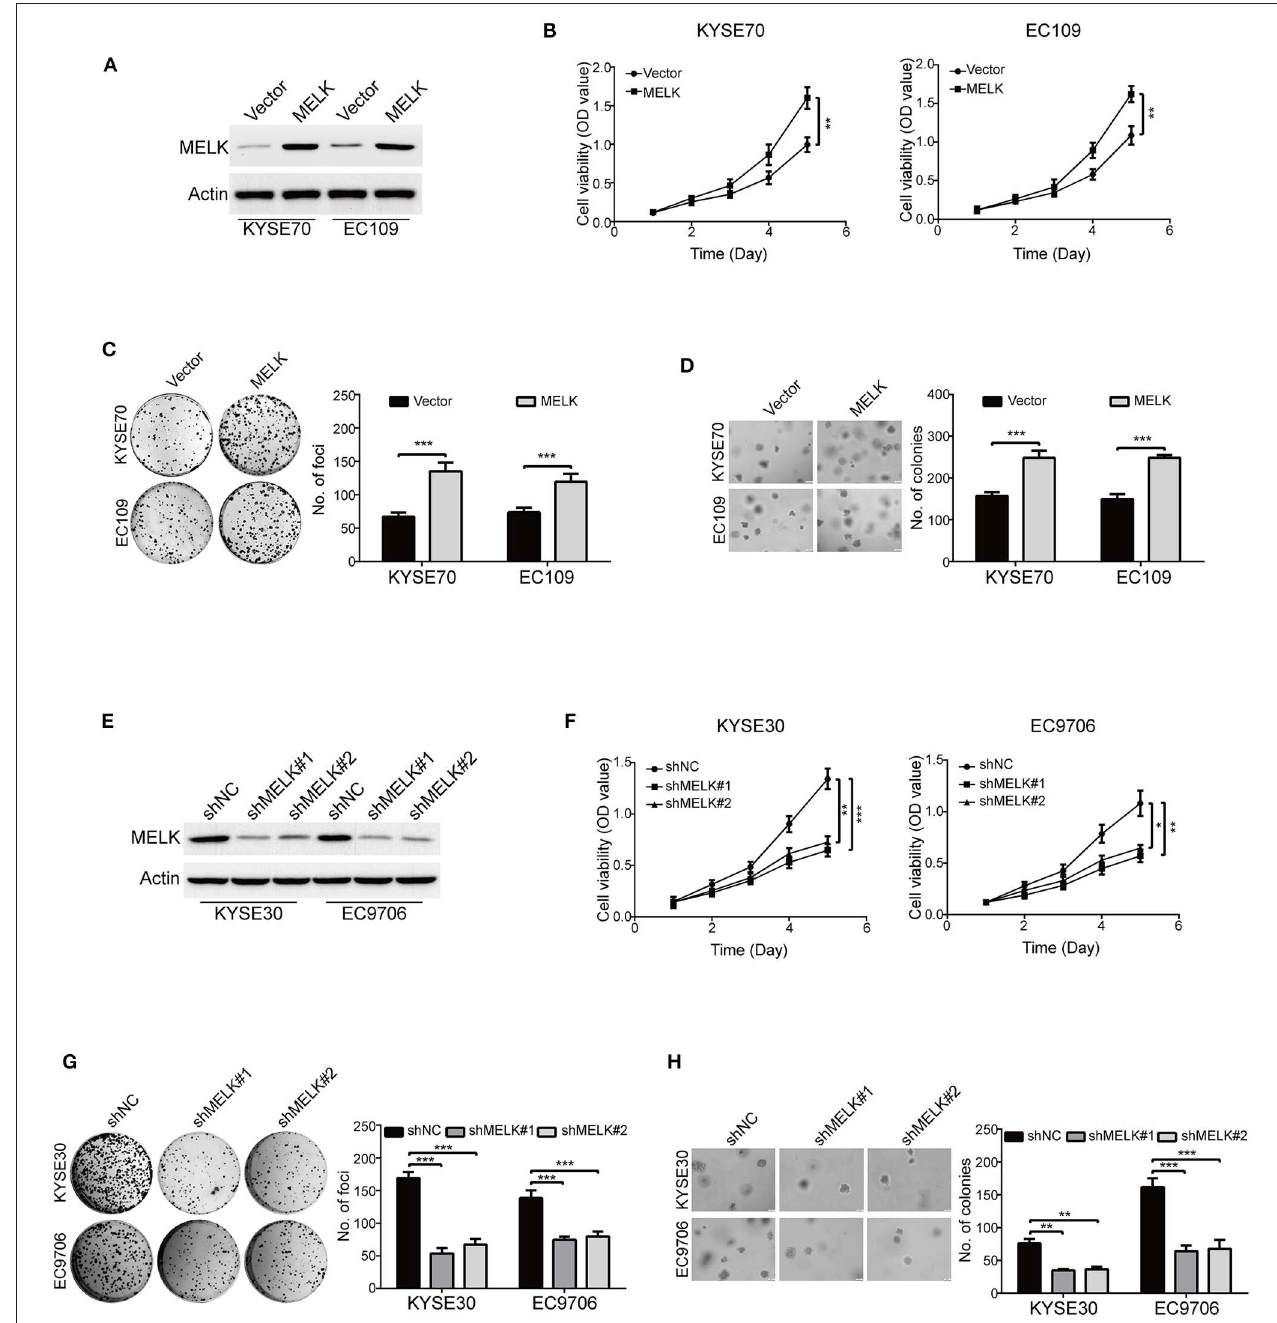
FIGURE 2 | MELK accelerates ESCC cell growth. (A) Western blotting analysis of MELK expression in ESCC cells (KYSE70 and EC109) stably transfected with MELK plasmid (MELK) or the empty vector (Vector). (B) MTT assay was used to measure the viabilities of cells with MELK overexpression ( n = 5). Representative images (left) and statistics (right) of focus formation assay ( n = 6) (C) and colony formation in soft agar assay ( n = 6) (D) in ESCC cells stably transfected with MELK or empty vector. Scale bars, 100 µ m. ** P < 0.01 and *** P < 0.001 by Student’s t -test. (E) The effect of MELK-targeting shRNAs was confirmed by immunoblotting analysis. KYSE30 and EC9706 cells were stably transfected with two shRNAs (shMELK#1 and shMELK#2) against MELK or the scrambled shRNA (shNC). (F) The viabilities of ESCC cells with stable MELK depletion was measured by MTT assay ( n = 5). Silencing MELK could significantly decrease the number of focus formation ( n = 6 per group) (G) and colony formation in soft agar ( n = 6 per group) (H) . Quantification of colonies were shown in the bar chart. Scale bars, 200 µ m. * P < 0.05, ** P < 0.01, *** P < 0.001 vs. shNC; P -values were obtained by one-way ANOVA with post-hoc intergroup comparison with the Tukey’s test.